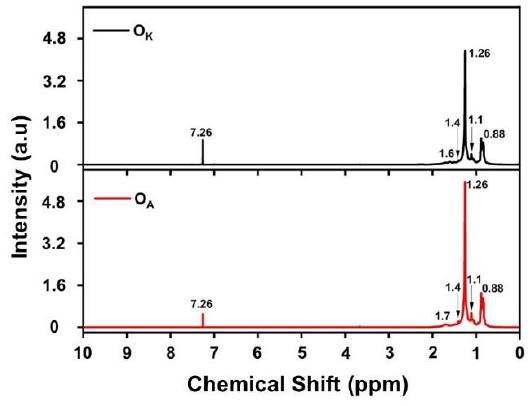
Figure 8. The NMR spectrum of O A and O K.